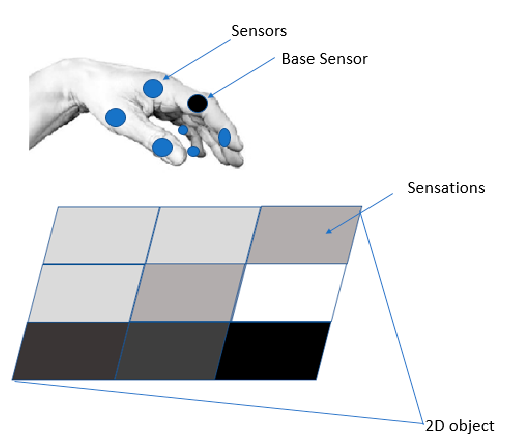
Figure 15. Object representation.